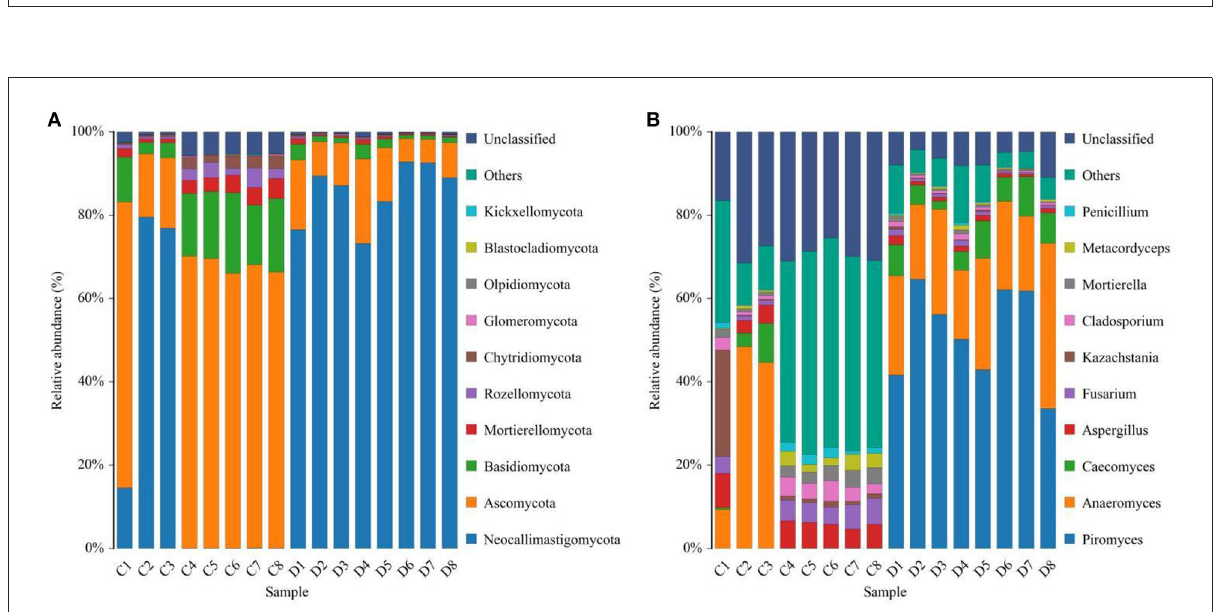
FIGURE3 Effects of diarrhea on gut fungal composition in horses. (A) The composition of dominant fungi at the phylum level. (B) The composition of dominant fungi at the genus level. C and D represent healthy and diarrheic groups, respectively.